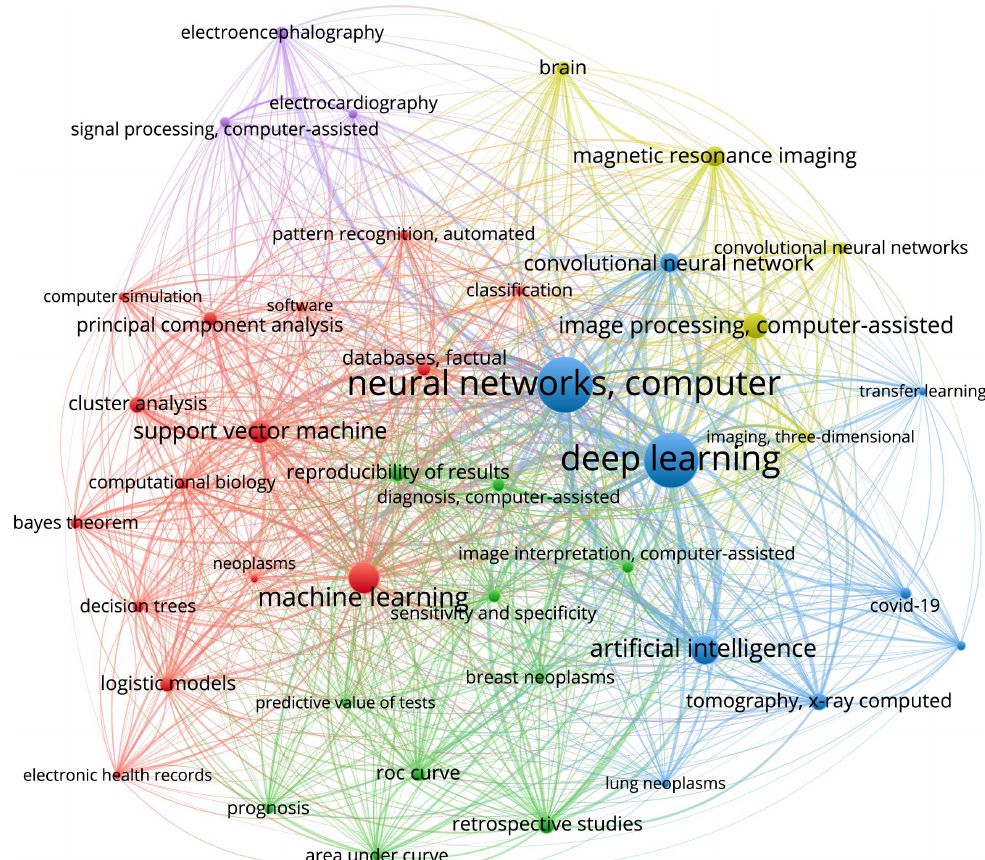
Figure 3. The co-occurrence network constructed using VOSviewer. The size of the nodes are determined by the weight of the corresponding item that indicate the importance of the item, and the color is determined by the cluster to which the item belongs. The methodology of VOSviewer visualization technique is provided in details in